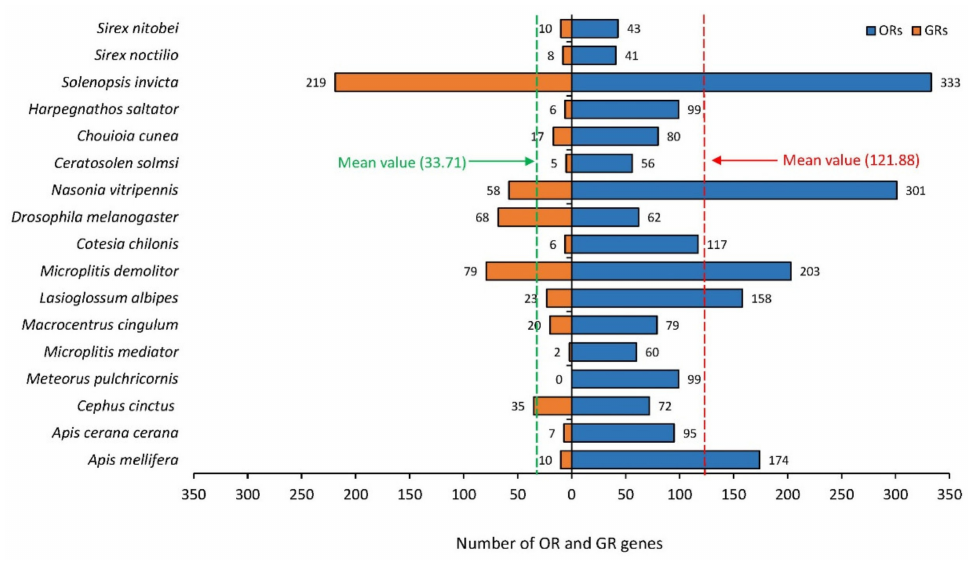
Figure 9. The number of ORs and GRs in 17 different Hymenoptera insects. The number near the bar column represents the number of genes in different insects, and the red and green dashed lines represent the average number of OR and GR genes in 17 species of Hymenoptera,